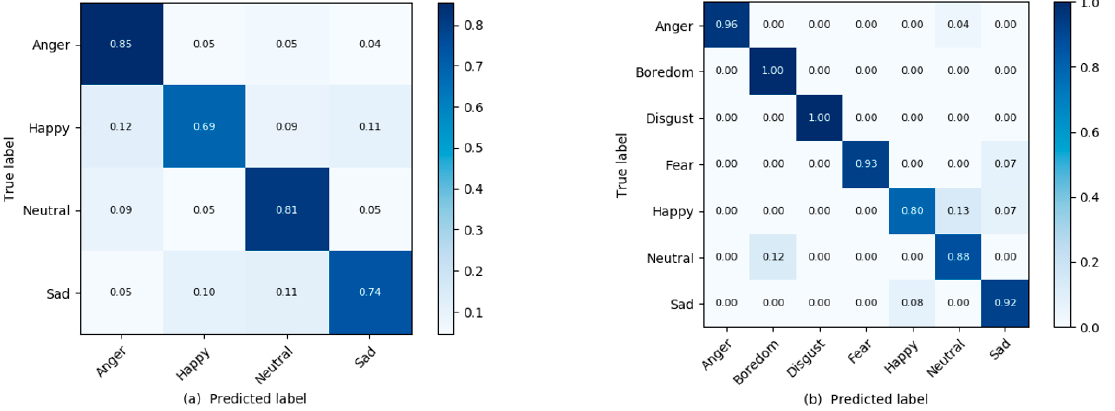
Table 7. The comparison of the proposed model in term of time complexity and accuracy using the suggested speech datasets with the baseline SER methods.